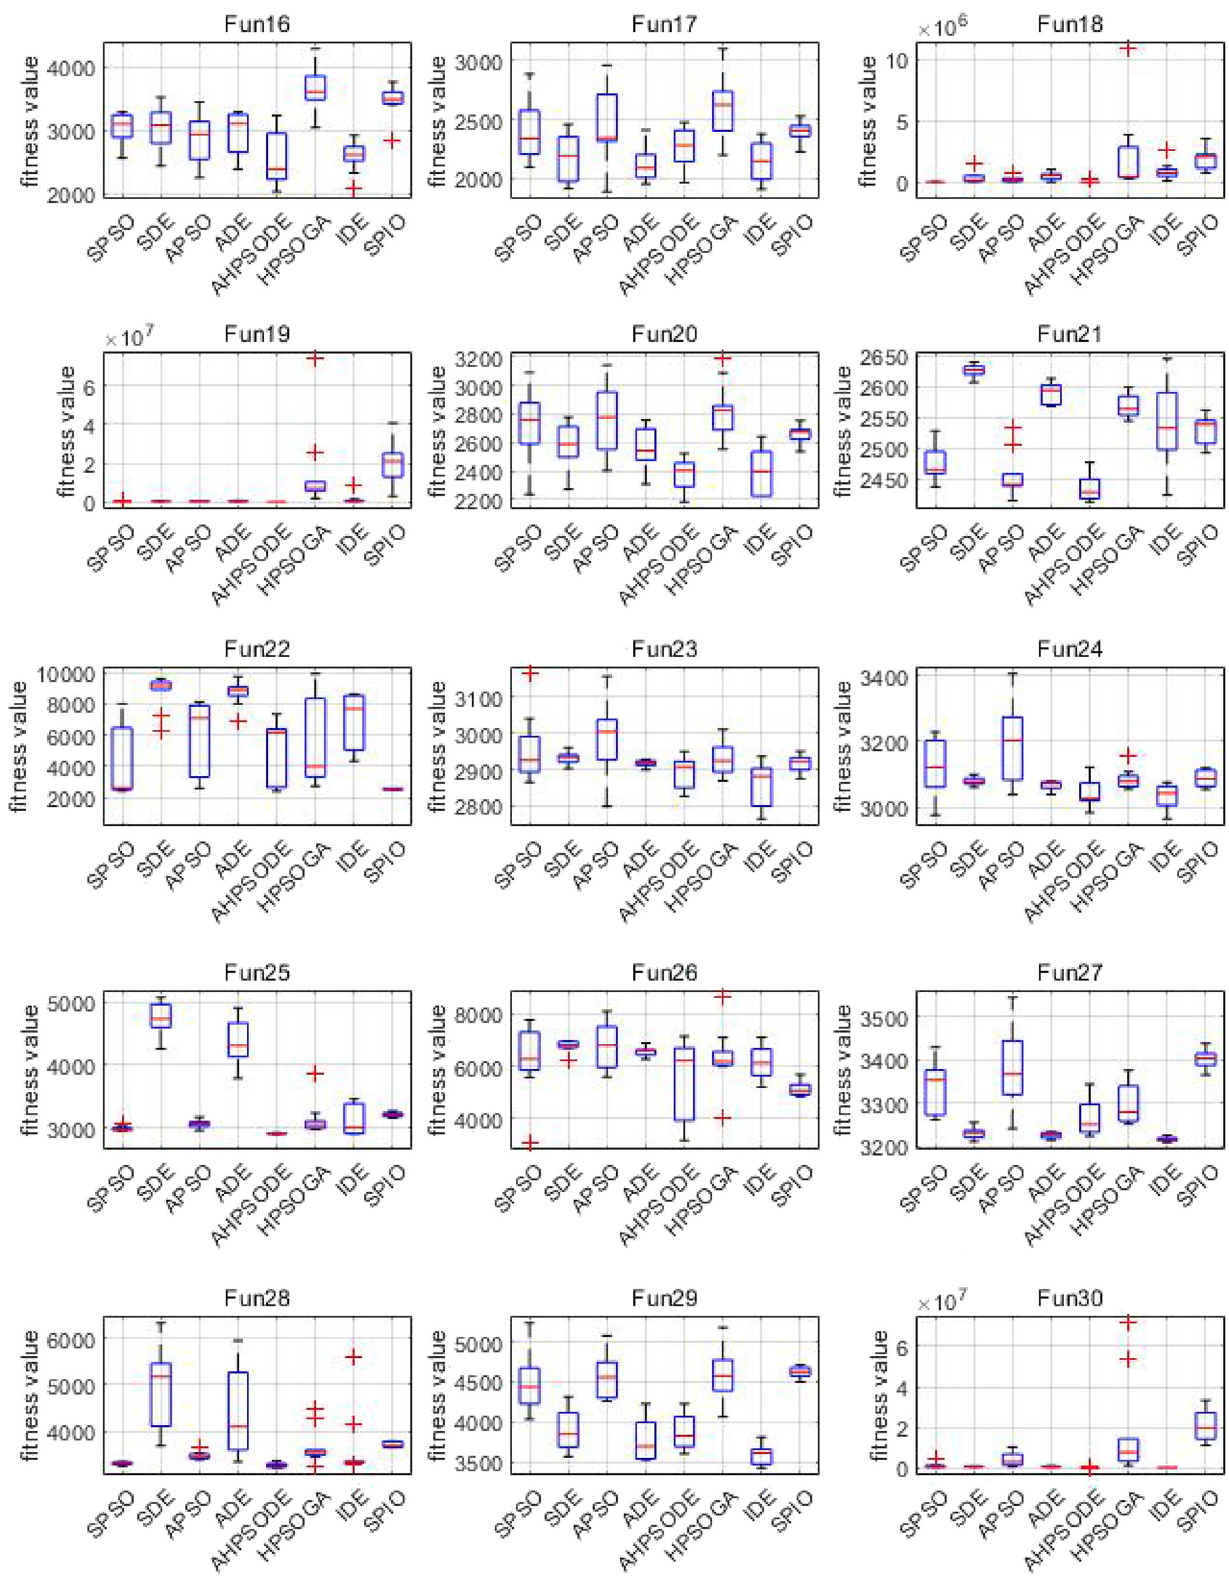
Fig. 20 Box plot of different algorithms on CEC 2017 at 30-D (Fun